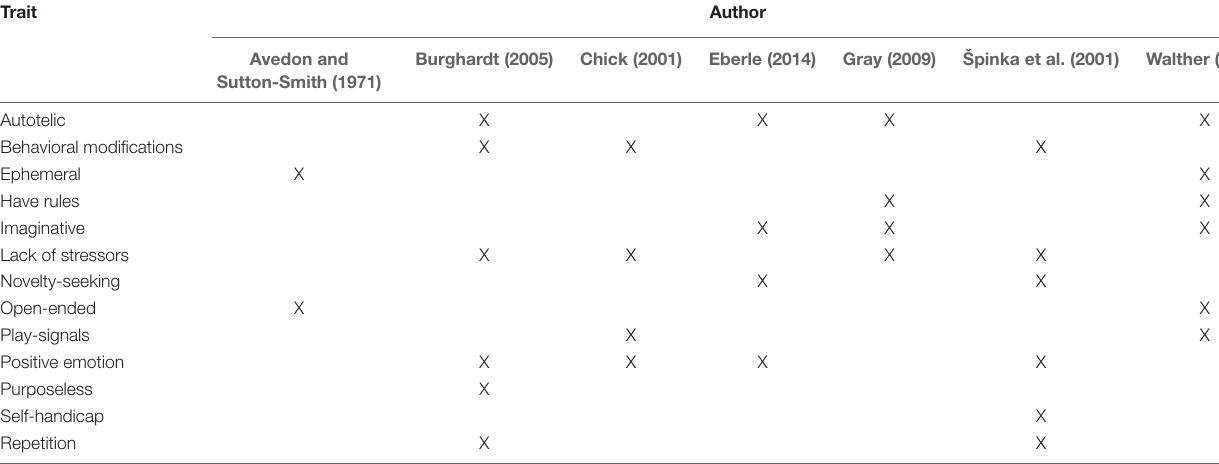
TABLE 1 | Traits presented in definitions of “play.”